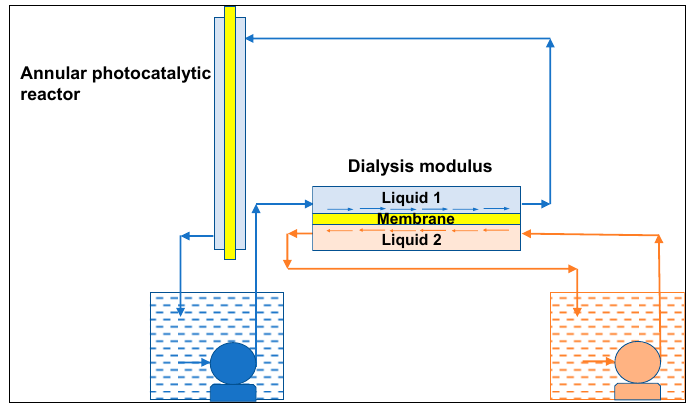
Figure 12. Scheme of the system.